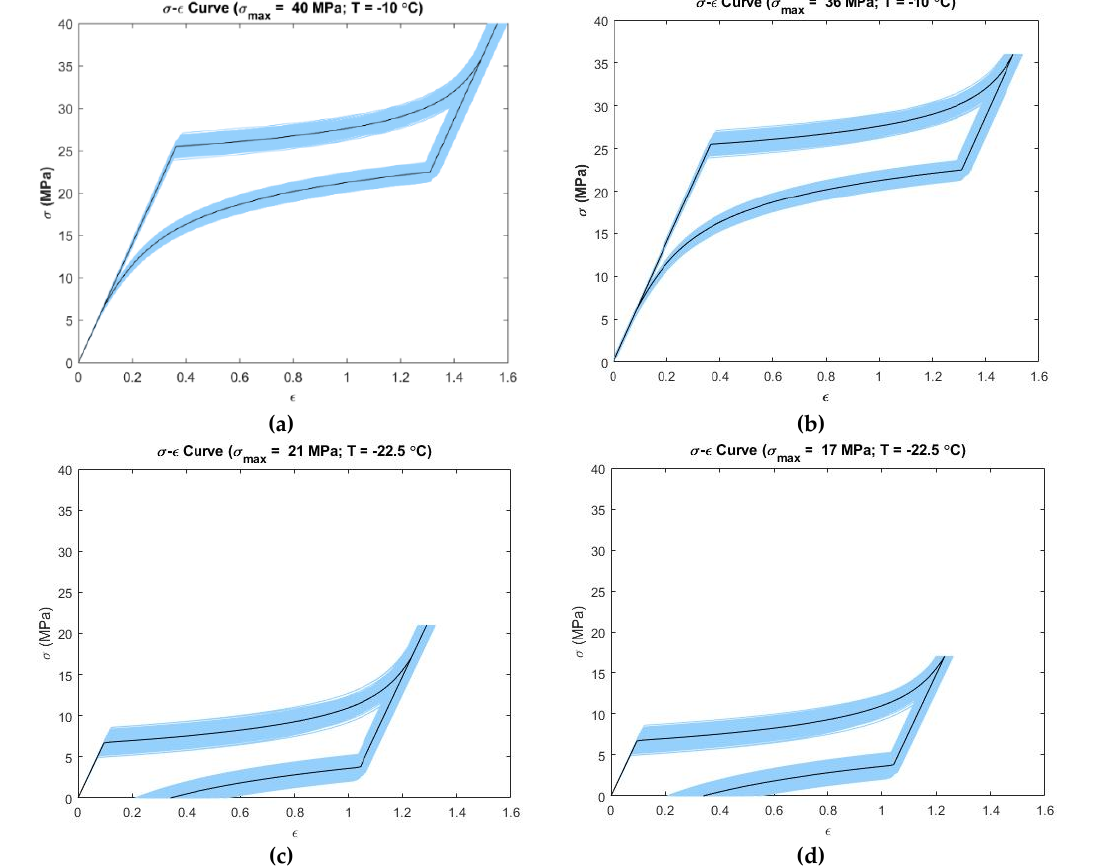
Figure 3. Confidence intervals (5–95 percentile) at simulated temperatures and maximum loading stress for the Tanaka model (the deterministic curve is shown in dark color; the deformation size is shown in the form of strain ( (cid:15) ) on the x-axis): ( a ) T = − 10 ◦ C, σ max = 40 MPa; ( b ) T = − 10 ◦ C, σ max = 36 MPa; ( c ) T = − 22.5 ◦ C, σ max = 21 MPa; ( d ) T = − 22.5 ◦ C, σ max = 17 MPa.